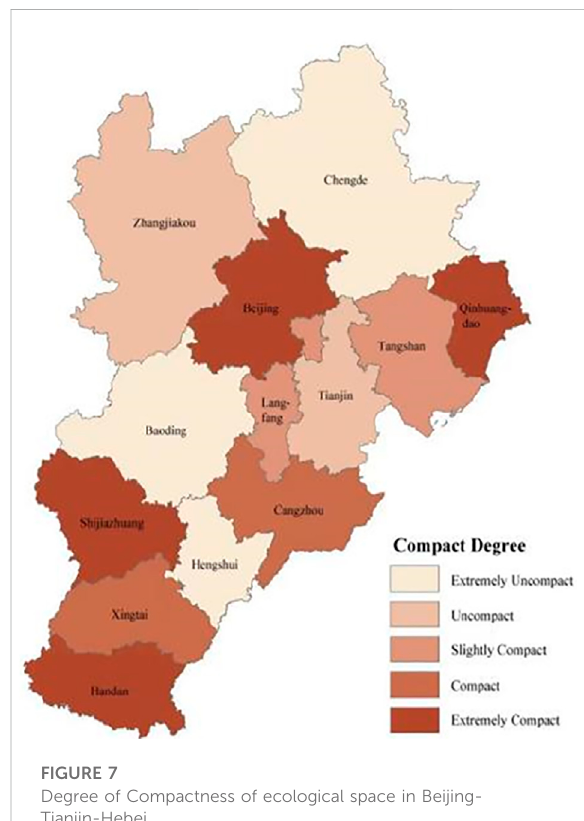
FIGURE 7 Degree of Compactness of ecological space in Beijing-